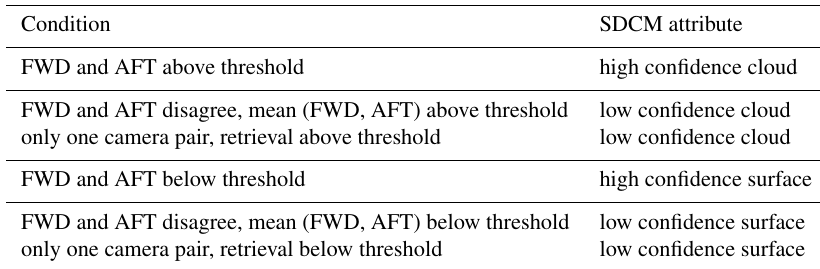
Table 1. Classification scenarios of MISR retrievals. The cloud height obtained using the nadir and the 26.1 ◦ forward-viewing camera pair (denoted by FWD) and the cloud height obtained using the nadir and the 26.1 ◦ aftward-viewing camera pair (AFT) are tested against the threshold height h min (Eq. 1) individually and then compared to one another to determine the stereo-derived cloud mask (SDCM) attribute.